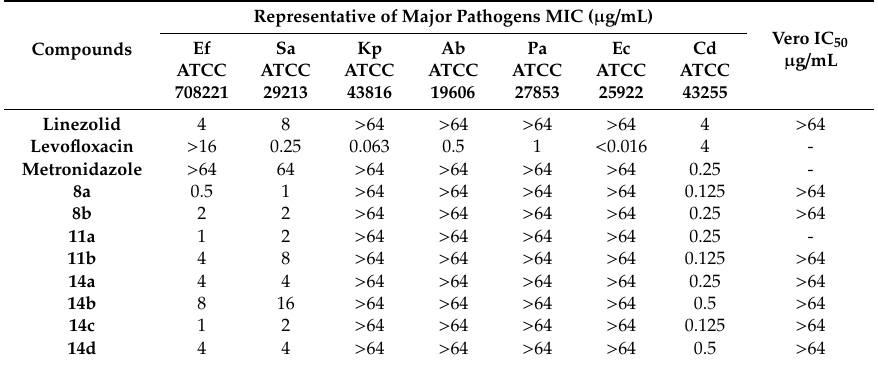
Table 2. Minimum inhibitory concentrations (MIC) of selected conjugate molecules against representative strains from seven major pathogen